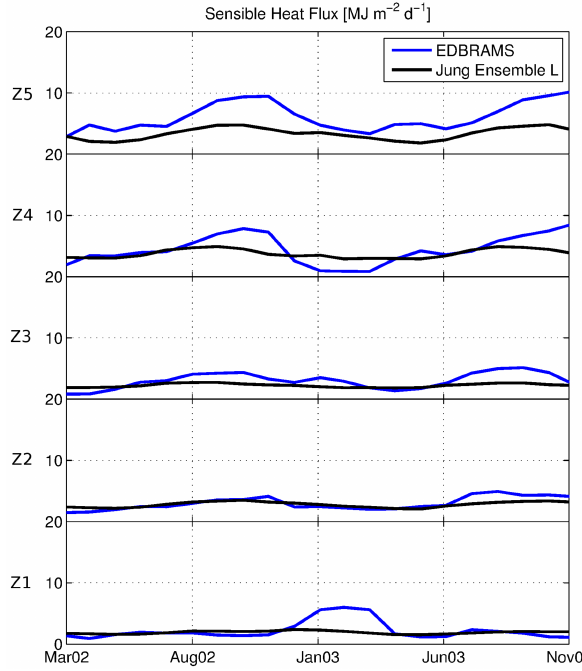
Figure E2. Mean monthly surface-to-atmosphere sensible heat flux from ED2-BRAMS and the synthesis product from Jung et al. (2011, 2009). Spatial means are calculated over the zones shown in Fig.